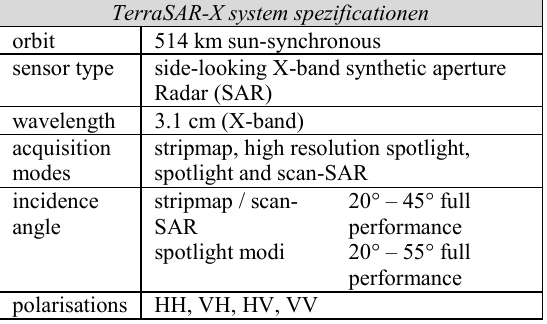
Table 2. TerraSAR-X system specifications For this work only high resolution spotlight mode (HS) data were used. The data has a spatial resolution between 1.1 m (single polarisation) - 2.2 m (dual polarisation) (azimuth) and 1.48 m - 3.49 m (ground range). Possible polarizations for the used high resolution spotlight mode are HH and VV (single polarization) and HH/VV dual polarization.